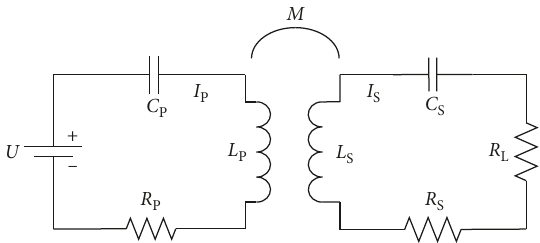
Figure 3: Equivalent circuit diagram of the transmitting and re- ceiving circuits.